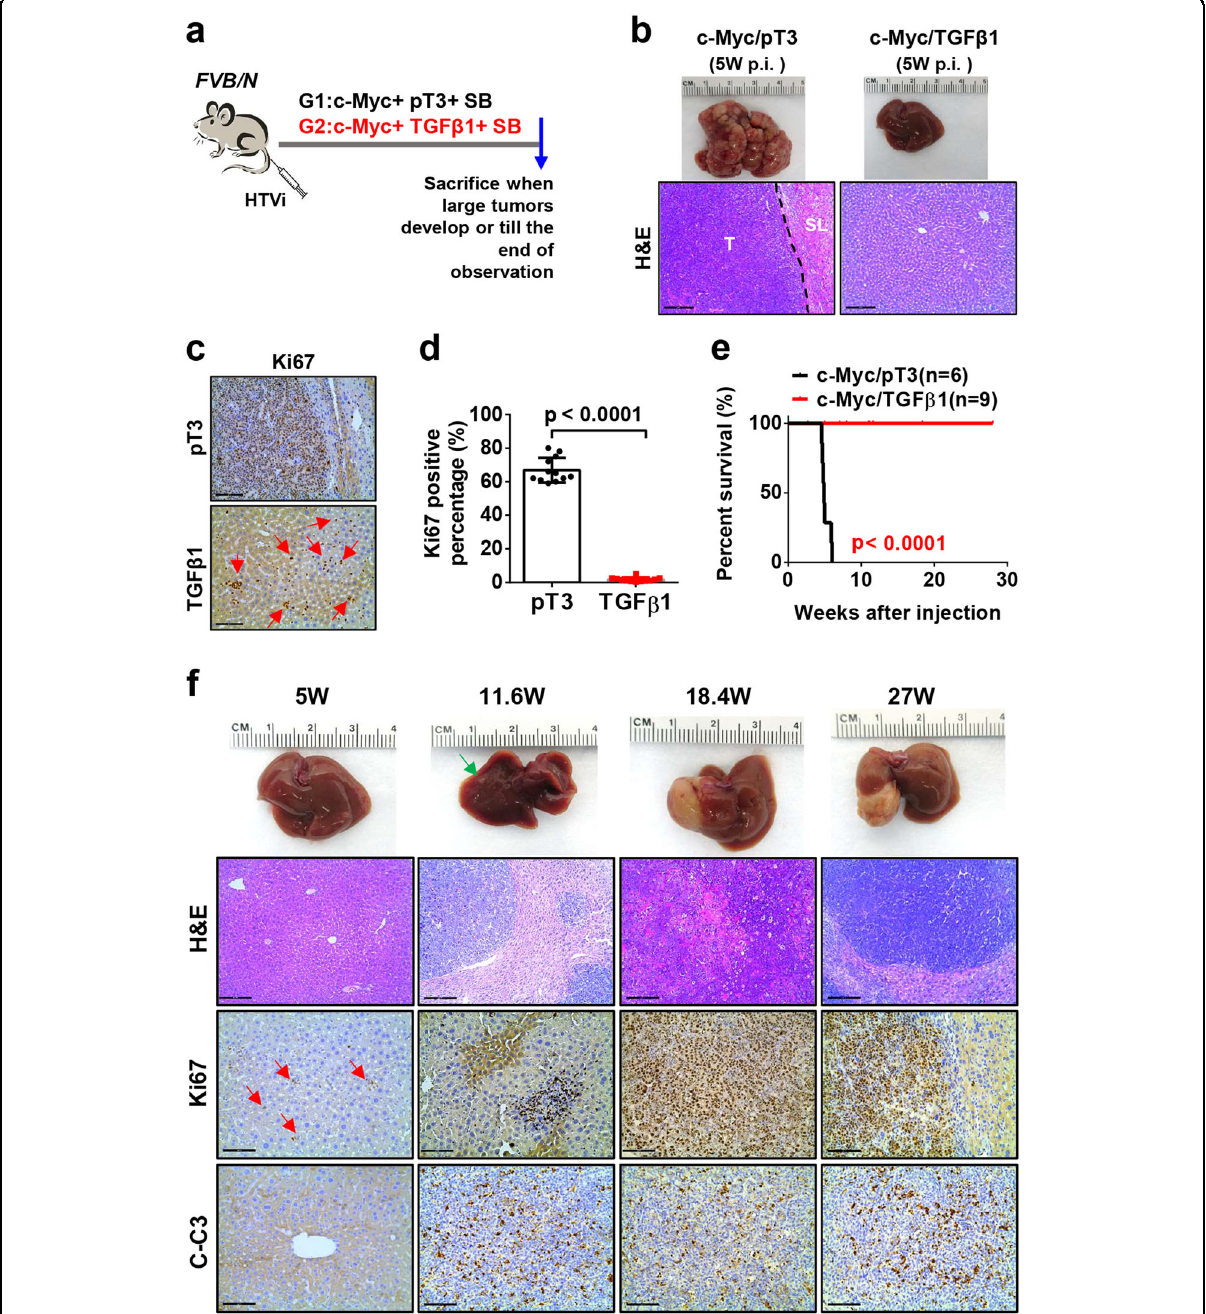
Fig. 2 Activation of TGF β 1 delays c-Myc induced hepatocarcinogenesis in mice. a Study design. FVB/N mice were injected with c-Myc/pT3/SB ( N = 6) or c-Myc/ TGF β 1/SB ( N = 9) plasmids. Mice were monitored and sacri fi ced when moribund. b Representative images of tumor and H&E staining in c-Myc/pT3 and c-Myc/TGF β 1 mouse livers at 5 weeks post injection (5 W p.i.). Scale bars: 200 μ m for 100X. c Representative images of Ki67 staining in c-Myc/ pT3 and c-Myc/TGF β 1 mouse livers at 5 weeks post injection (5 W p.i.). Red arrows indicate Ki67 + cells in c-Myc/TGF β 1 group. Scale bars: 100 μ m for 200X. d Quanti fi cation of Ki67 + cells percentages in in c-Myc/pT3 and c-Myc/TGF β 1 mouse livers. Student t test was applied for statistical analysis. e Survival curve showing that TGF β 1 impaired c-Myc induced hepatocarcinogenesis in mice. Kaplan – Meier method and log- rank test were applied. P < 0.0001. f Representative images of liver, H&E, Ki67, and Cleaved Caspase-3 (C-C3) immunohistochemical staining in c-Myc/ TGF β 1 group at different time points after injection. Green arrow indicates a tumor nodule on the surface of the right lobe of mouse liver. Red arrows indicate Ki67 + cells. Scale bars: 200 μ m for H&E, 100 μ m for Ki67 and